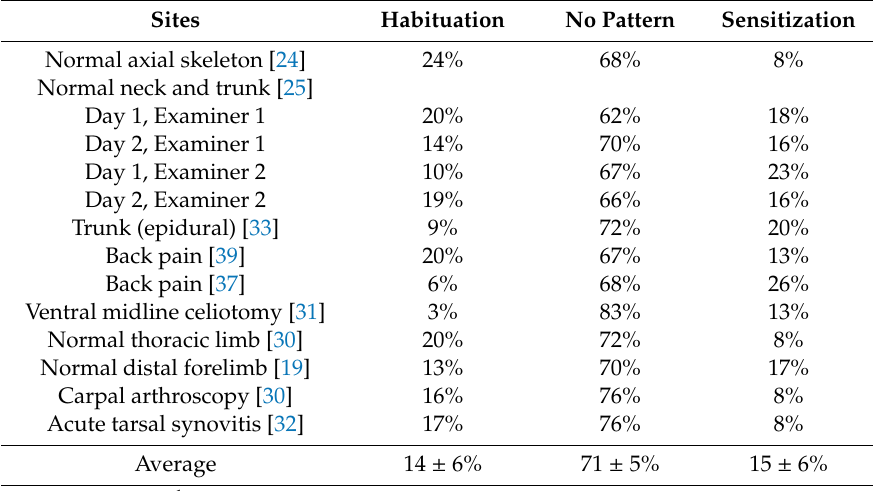
Table 6. Proportions of habituation, sensitization, and no consistent pattern of change.